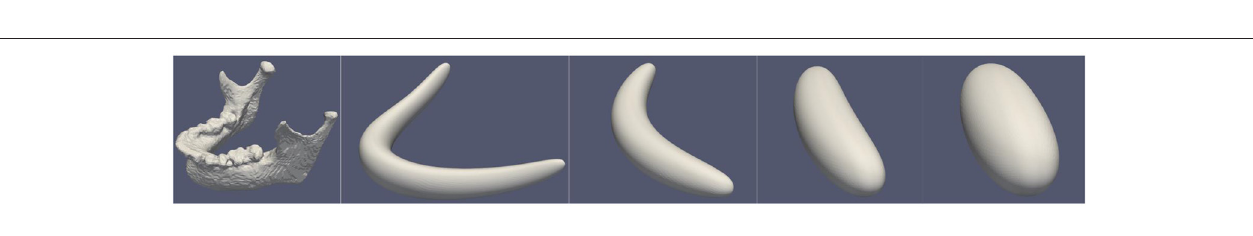
FIGURE 10 | Conformalized mean curvature flow on a